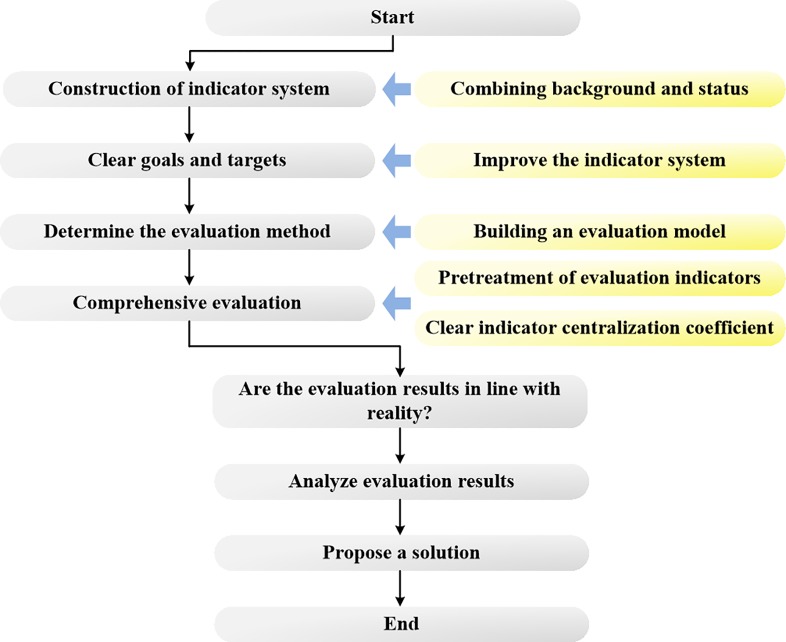
Financial benefit evaluation process of the investment project.